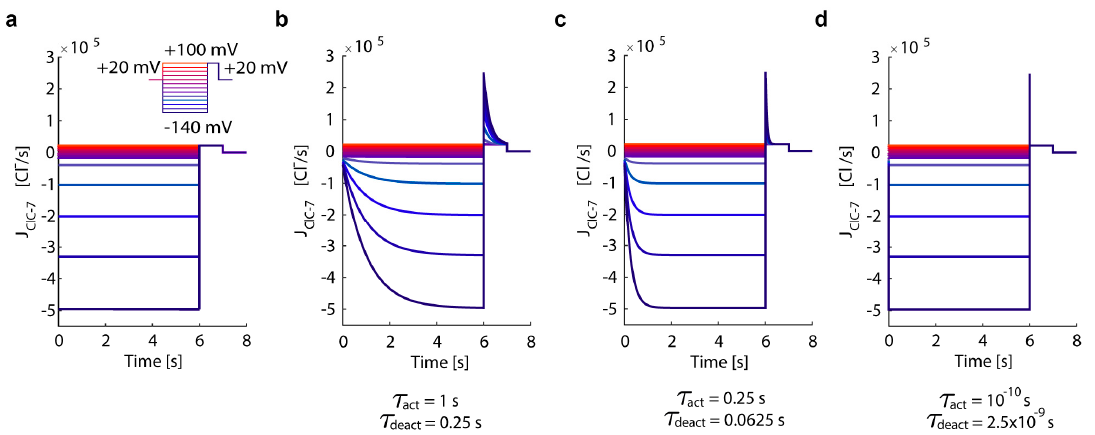
Figure 2. In silico simulation of voltage-clamp traces of ClC-7. Starting from a resting potential of +20 mV, we simulated a pulse protocol from − 140 mV to +100 mV in 20-mV steps for 6 s, followed by +100 mV for 1 s, after returning to the resting potential. Depicted are the turnover rates for ( a ) ClC-7 fast antiporter, and ( b ) ClC-7 WT antiporter with relatively slow (de) activation kinetics ( τ act = 1 s), ( c ) a ClC-7 antiporter with moderately accelerated (de) activation kinetics ( τ act = 0.25 s), and ( d ) a ClC-7 antiporter with an extremely accelerated (de) activation kinetics ( τ act = 10 − 10 s). The colour gradient varies from dark blue for negative voltages to red for positive voltages (cytosolic potential defined as zero) as indicated in the pulse protocol (inset in ( a )).